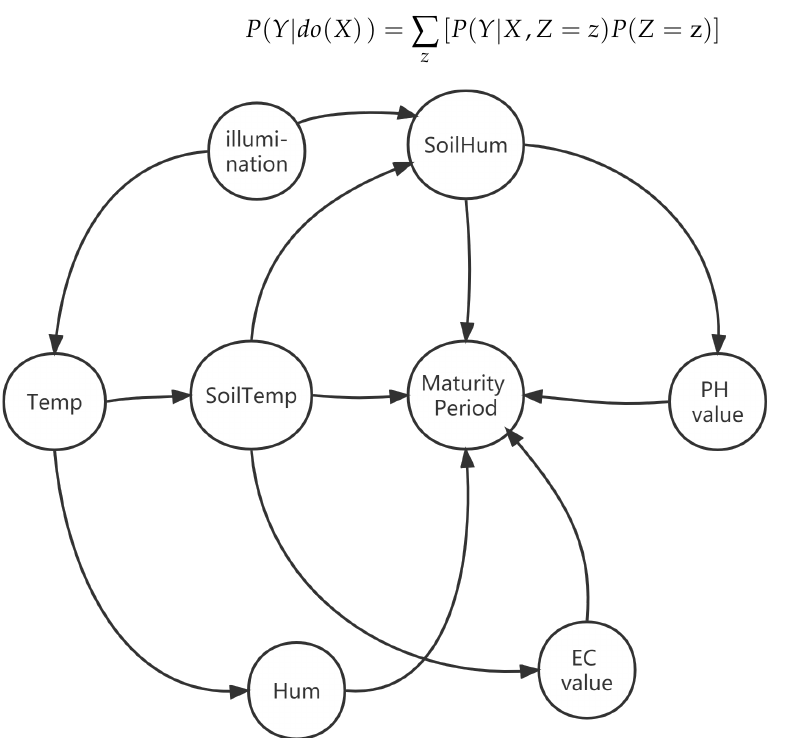
Figure 6. Causal diagram of environment and leafy